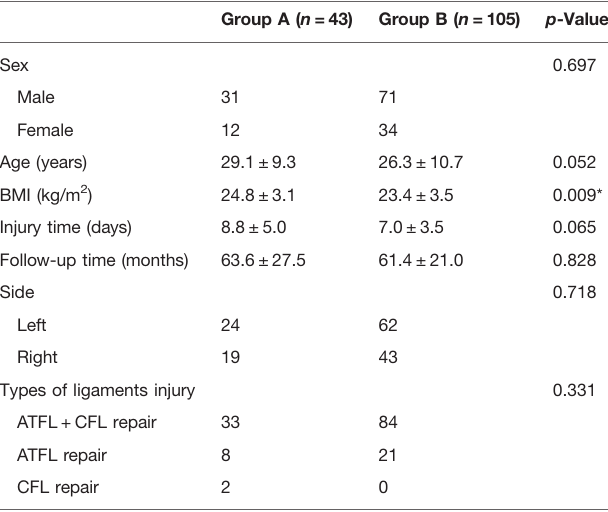
TABLE 1 | Demographic data and characteristics of two